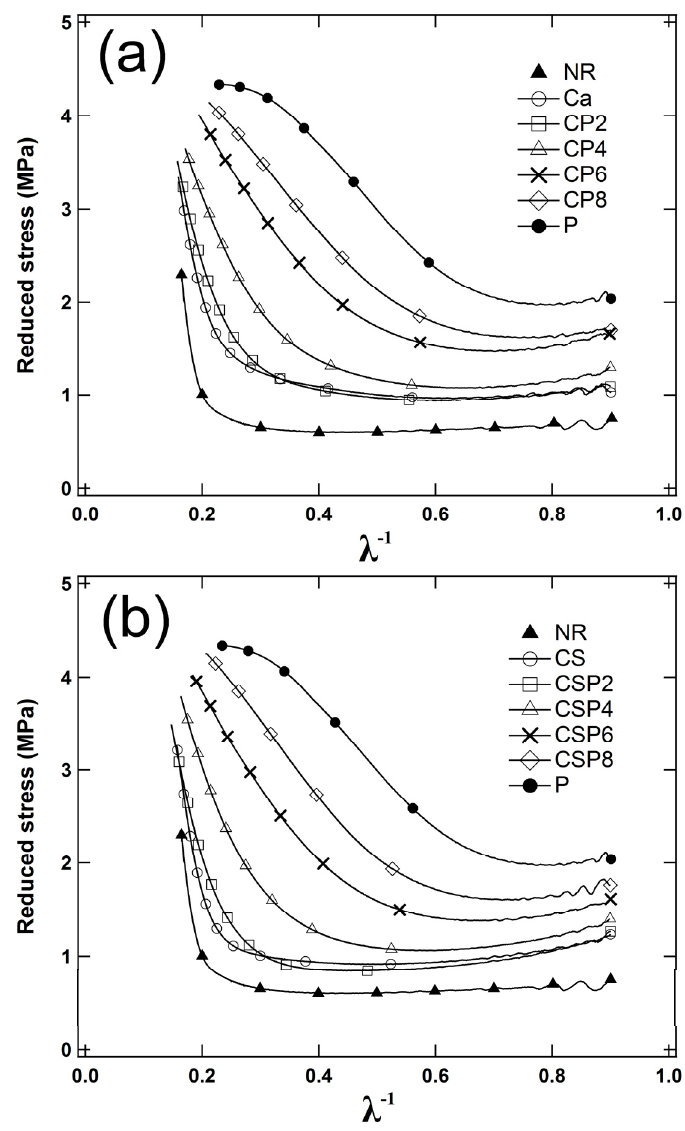
Figure 6. Reduced stress of rubber composites. ( a ) CaCO 3 ( b ) CaCO 3 modified with stearic acid.